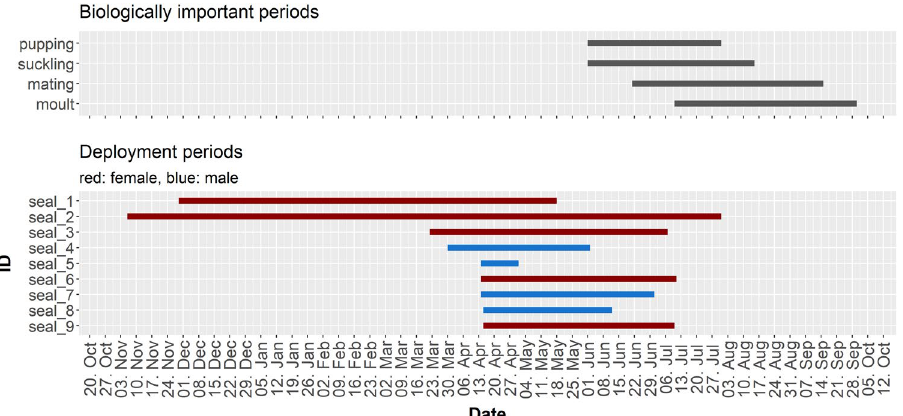
Figure 2. Top: Biologically important periods for harbour seals in the region. Bottom: Deployment periods throughout the year separated by ID and coloured by sex. Note that seal_1 was tagged in 2019 and seal_2 in 2020, while the other deployments took place in 2021; see Table